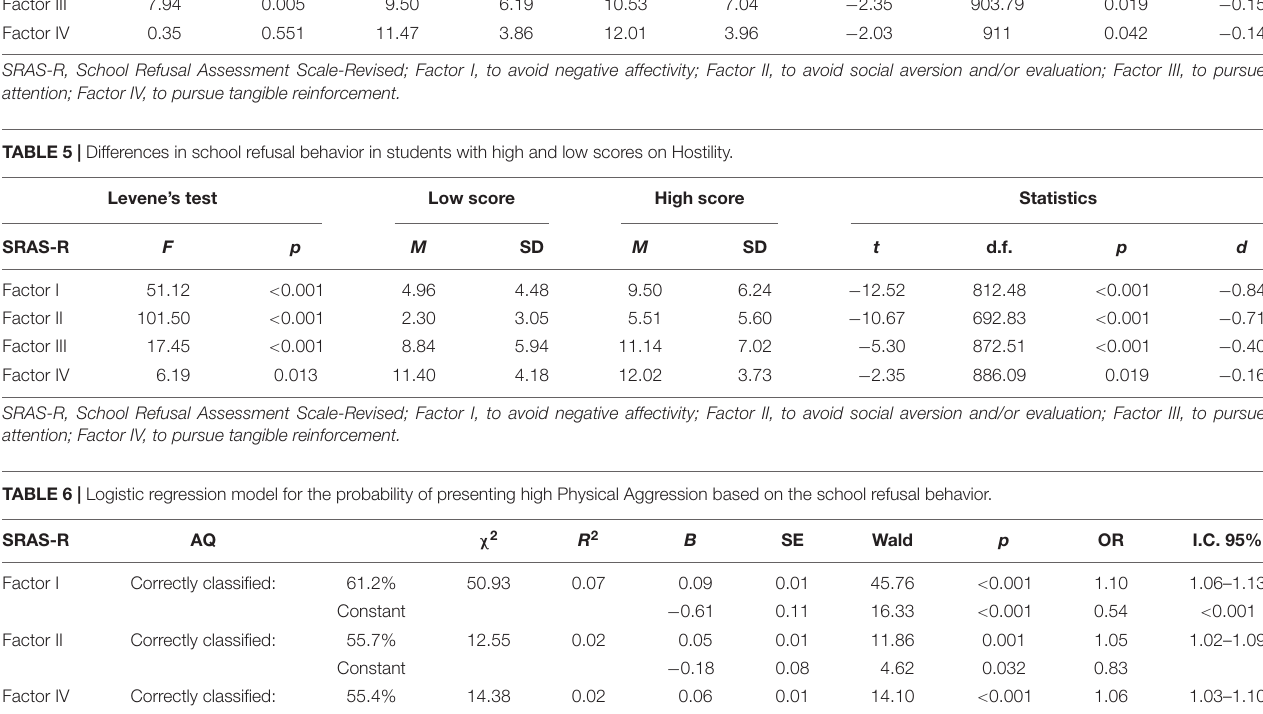
Table 7 offers the results of the logistic regression analysis for the probability of receiving high scores on Verbal Aggression based on the type of school refusal. The proportion of correctly